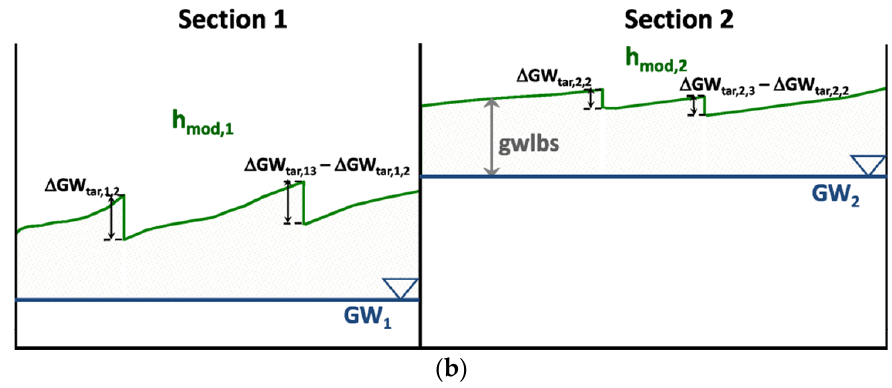
Figure 5. Cross-sectional view of surface ( h ) and simplified groundwater ( GW ) levels in a wetland with a groundwater control system of ditches and weirs. ( a ) Original system with sub-areas. ( b ) Aggregated system with collated sections and modified surface h mod (gwlbs—groundwater levels below surface, GW tar —target groundwater levels).